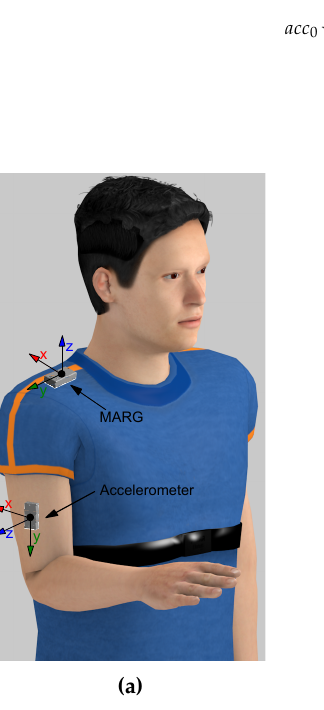
Figure 3. ( a ) Reference orientation of the accelerometer and the MARG. ( b ) Plane Π shaped by the X axis and Y axis of acc 0 ˜ R acc